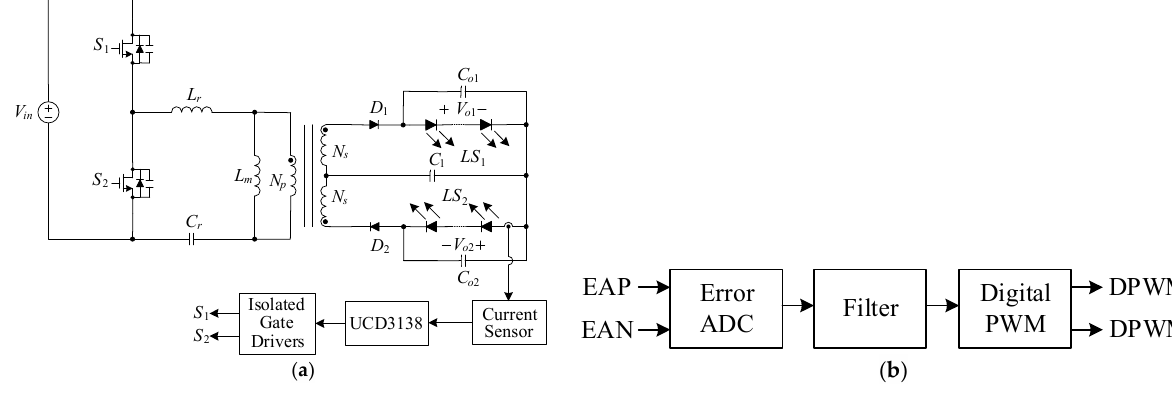
Figure 10. System control: ( a ) block diagram; ( b ) UCD3138 control kernel.